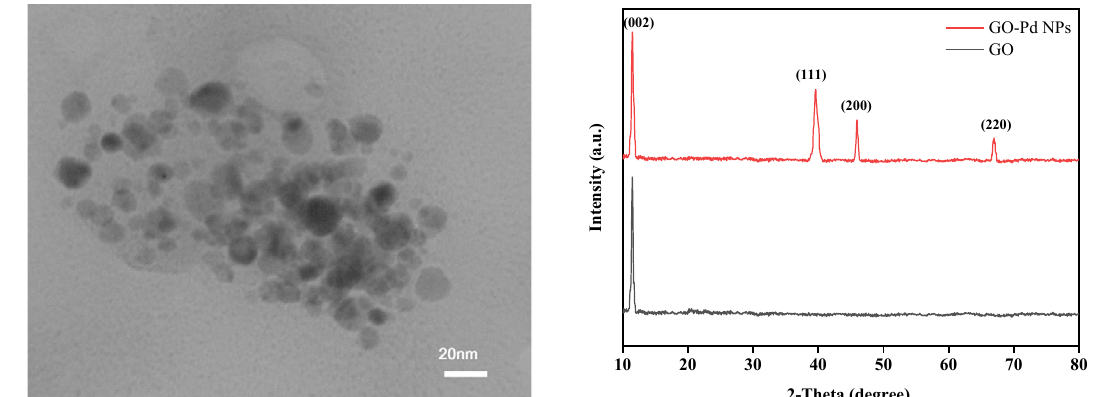
Fig. 2. TEM images of Pd NPs Fig. 3. XRD patterns of GO and GO-Pd NPs.